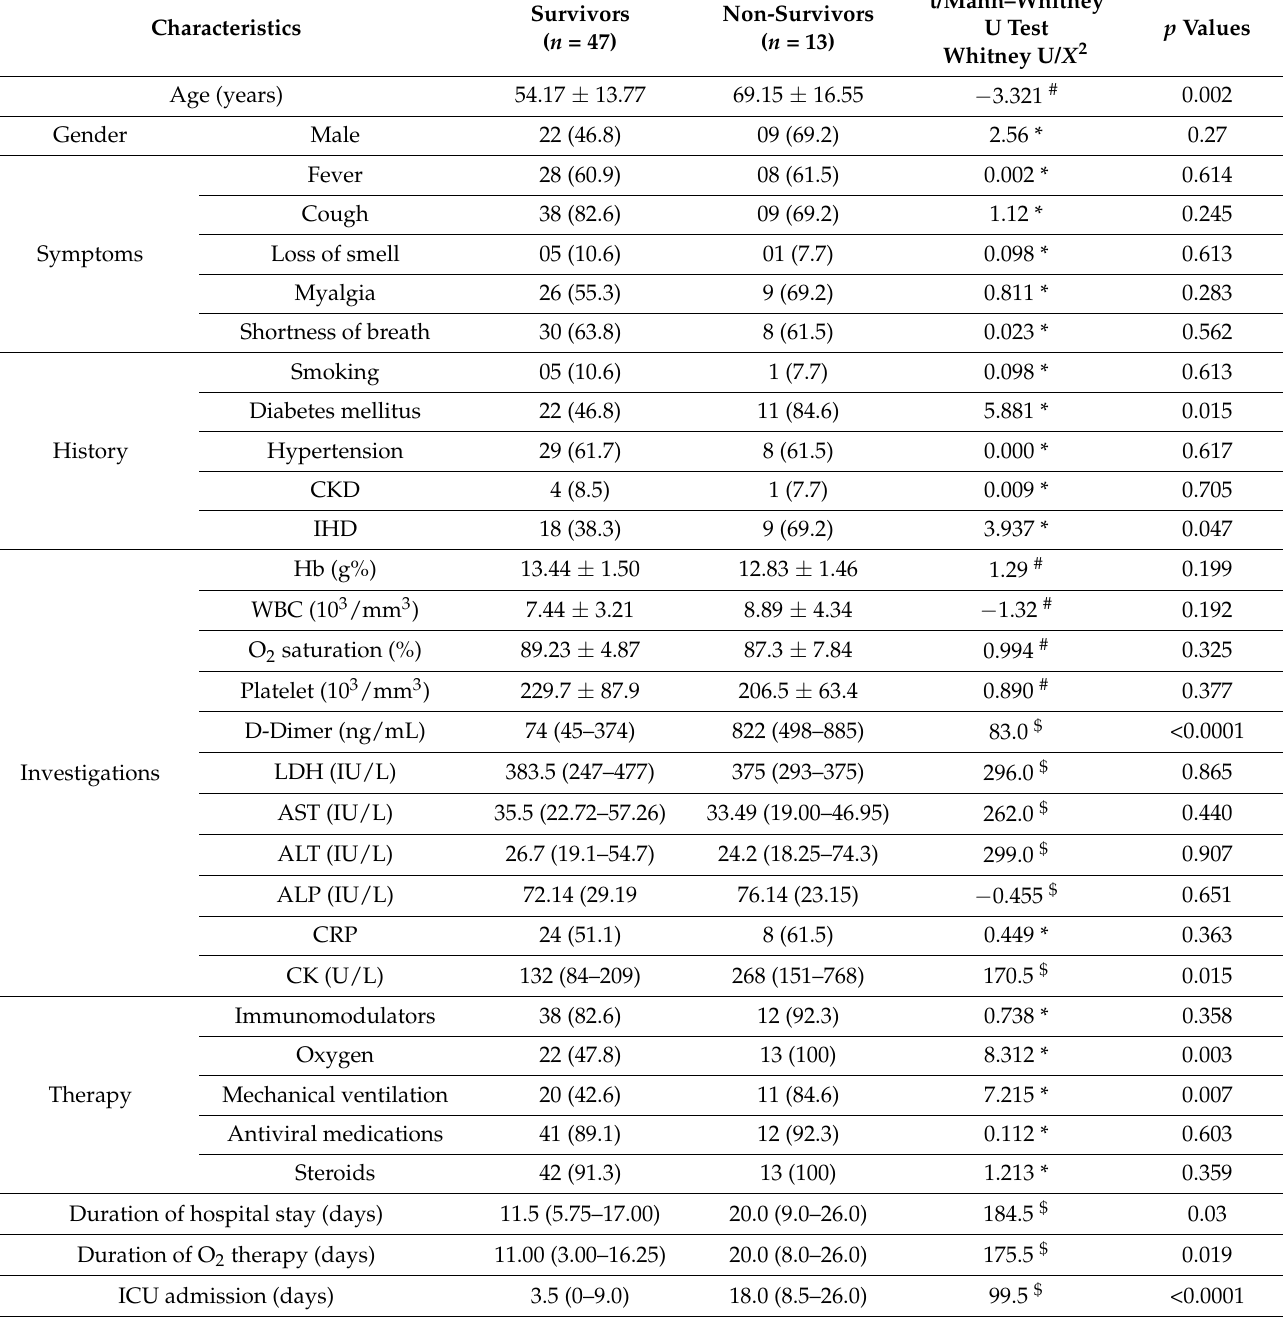
Table 1. Characteristics of study